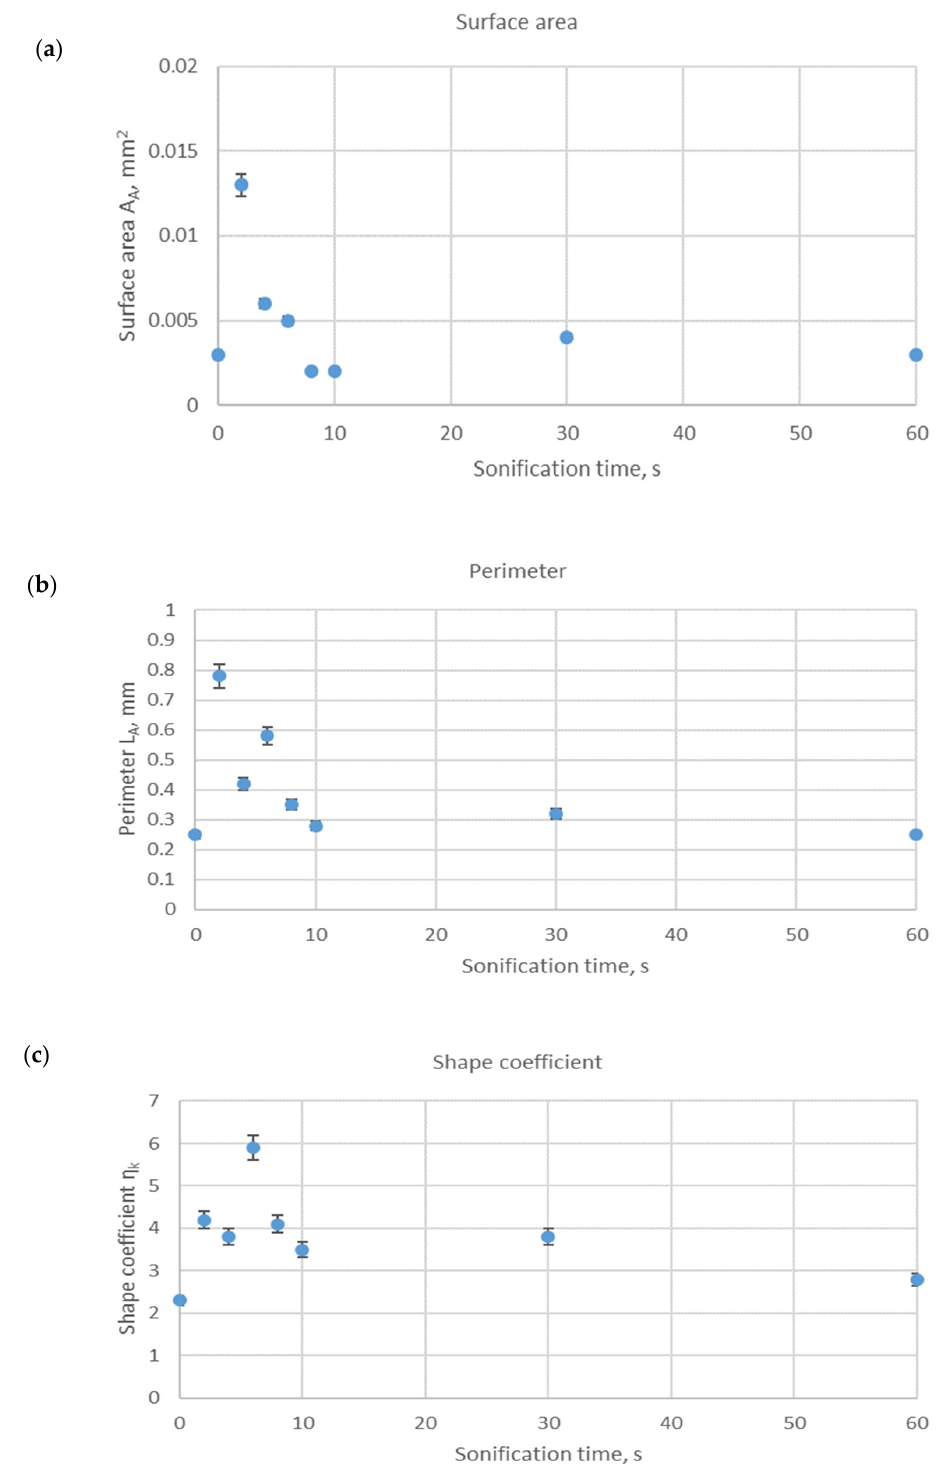
Figure 1. Sonification time-dependent changes of average values of ( a ) surface area ( b ) perimeter, and ( c ) shape coefficient for the Renfloc 25489 slides.